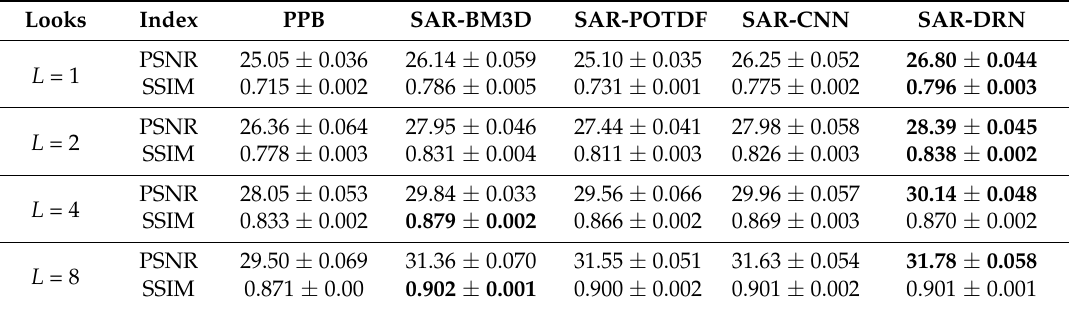
Table 3. Mean and Stand Deviation Results of PSNR (dB) and SSIM for Building with L = 1, 2, 4, and 8.